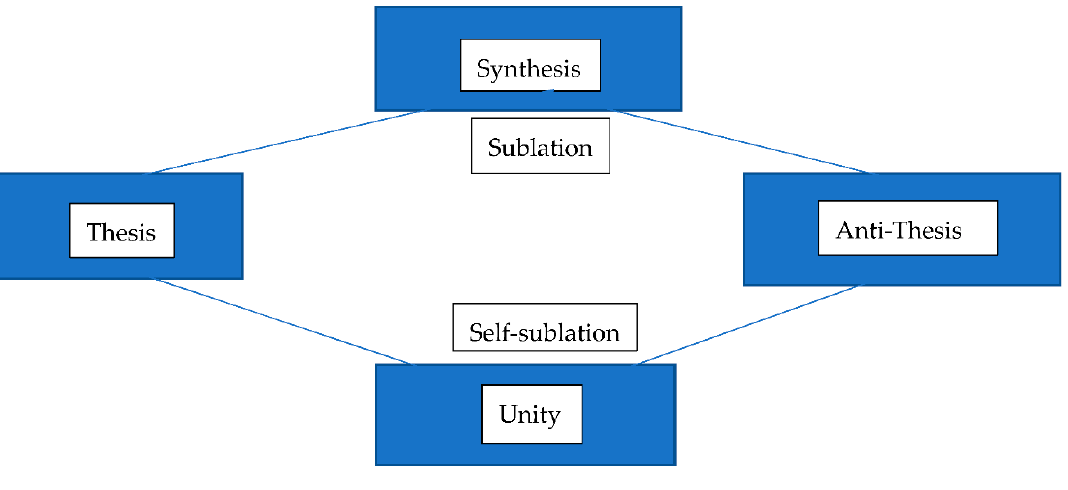
Figure 1. Dialectics. Figure 1.